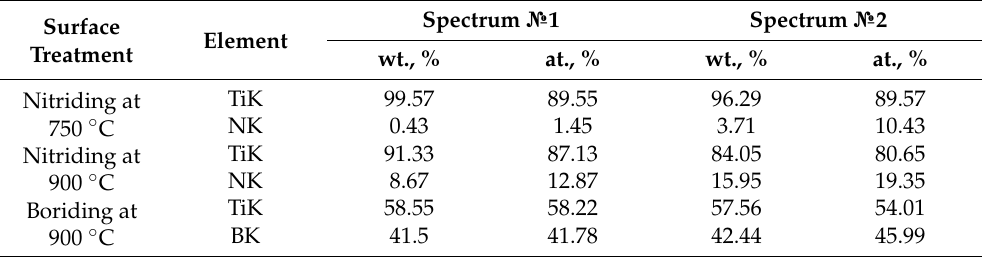
Figure 5. BSD and EDX analysis of titanium Grade 2 surface after nitriding at temperatures of 750 °C ( a ) and 900 °C ( b ) and after boriding ( c ). Table 2. EDX analysis of titanium Grade 2 surface after surface treatment (see Figure